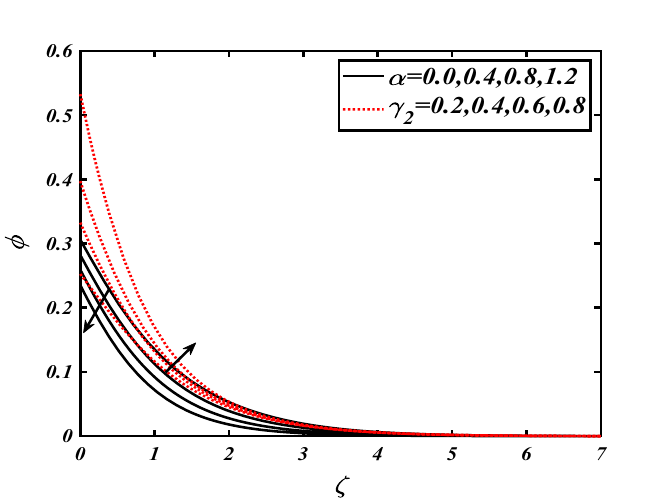
Figure 8. Illustration of α and γ 2 over nanoparticles concentration φ when Pr = 2.0, Rd = 0.4, γ 1 = 0.3, Nt = 0.3, S = 0.5, (cid:31) = 0.5, β = 0.2